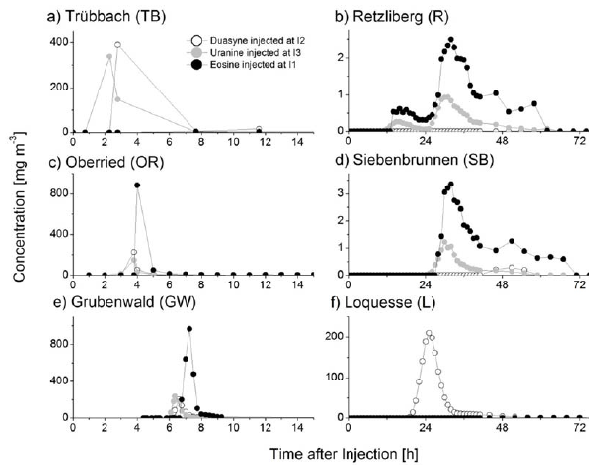
Fig. 5. Tracer breakthrough curves at six sampling sites (TB, OR, Figure 5 GW, R, SB and L) after tracer injection at locations I1, I2 and I3 injection (see Fig. 1) on Glacier de la Plaine Morte in August